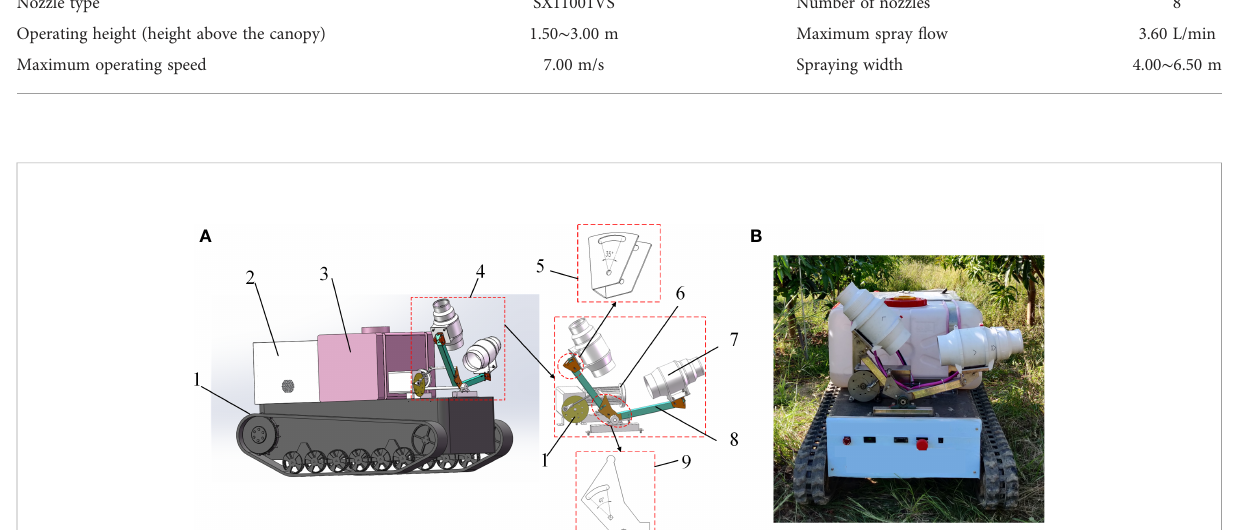
FIGURE 4 Small swing-arm sprayer. (A) Small swing-arm sprayer 3D model. (B) Small swing-arm sprayer prototype. 1. Crawler type walking chassis 2. Booster renewal mechanism 3. Liquid tank 4. Swing-arm air-assisted spraying mechanism 5. Angle adjustment parts 6. Direct current reducer motor 7. Piping fan 8. V-shaped swing-arm support bar 9. Driving fan